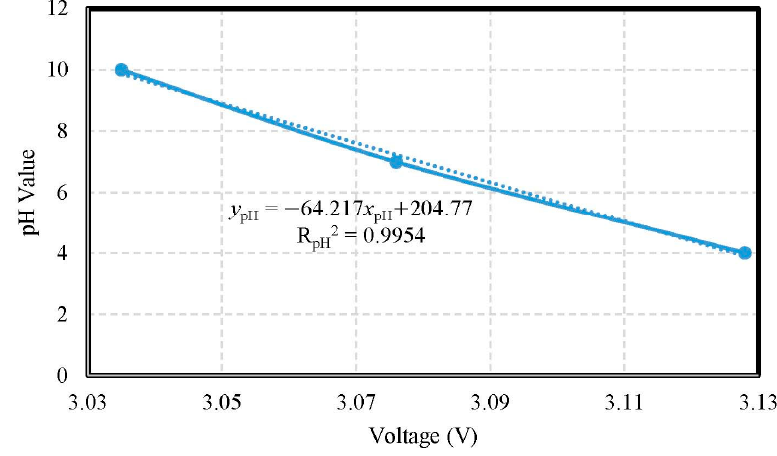
Figure 8. The calibration curve of pH values.